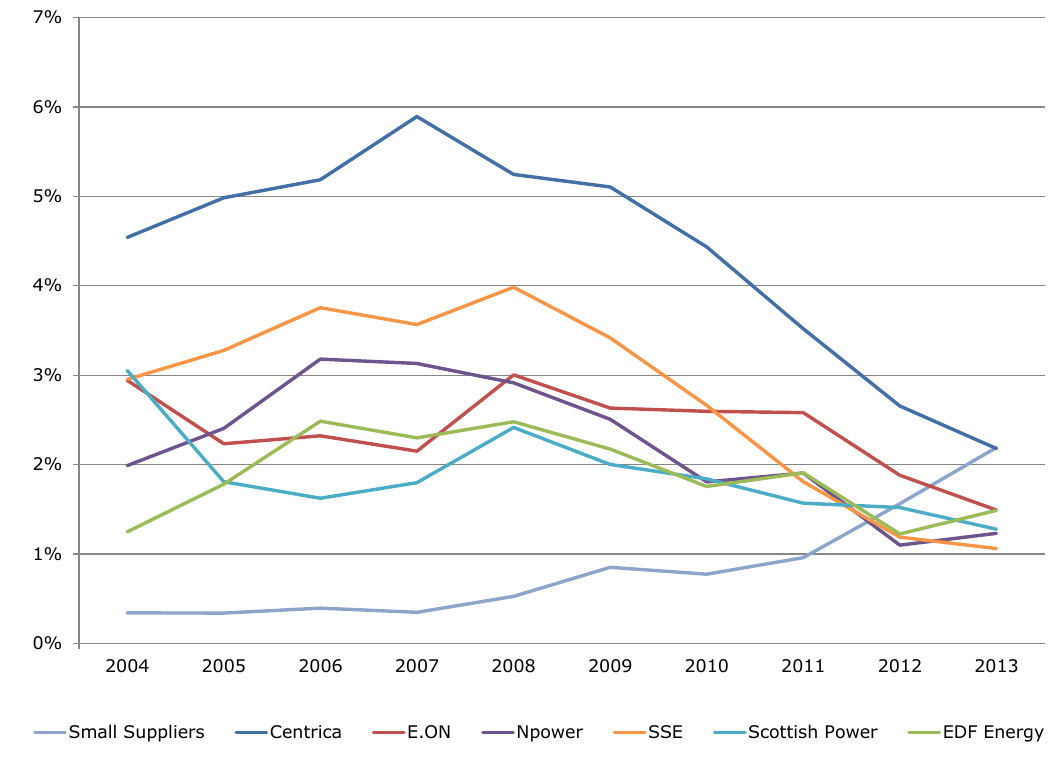
Figure 29: New electricity customers as a proportion of all electricity customers 2004 to